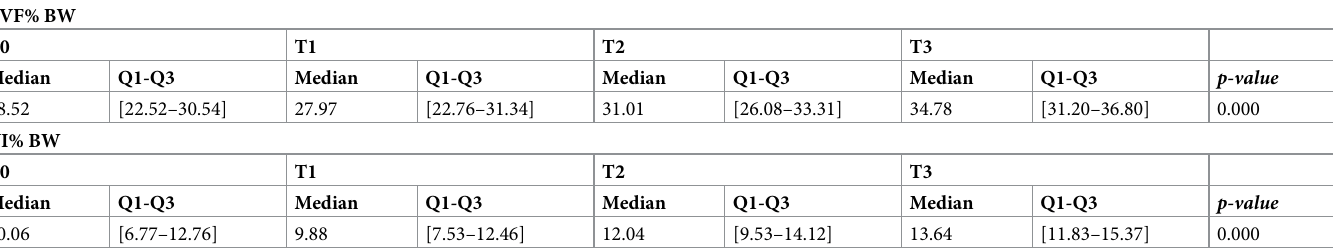
Table 2. GFRs for the operated limb from T0 to T3: Friedman’s ANOVA test values for related samples. PVF%